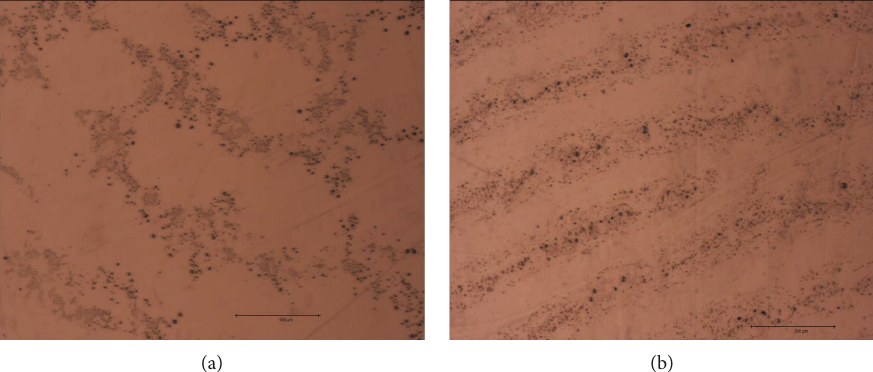
Figure 2: Images with optical microscope at 20X magni fi cation of third arti fi cial fi ngerprint (a) and a human fi ngerprint deposited by a man aging 25 years in low pressure condition (b).